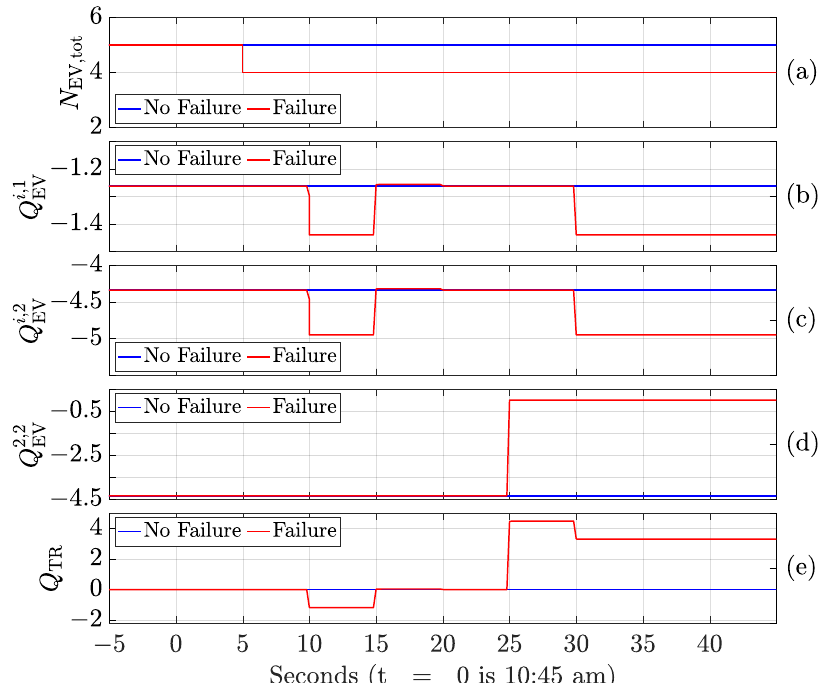
Figure 18. System response without and with communication failure case 2, ( a ) number of EVs present; ( b ) Q supplied by an online EV at Level 1 in kVAr; ( c ) Q supplied by an online EV at Level 2 in kVAr; ( d ) Q supplied by EV-2 at Level 2 in kVAr; ( e ) transformer reactive power in kVAr.